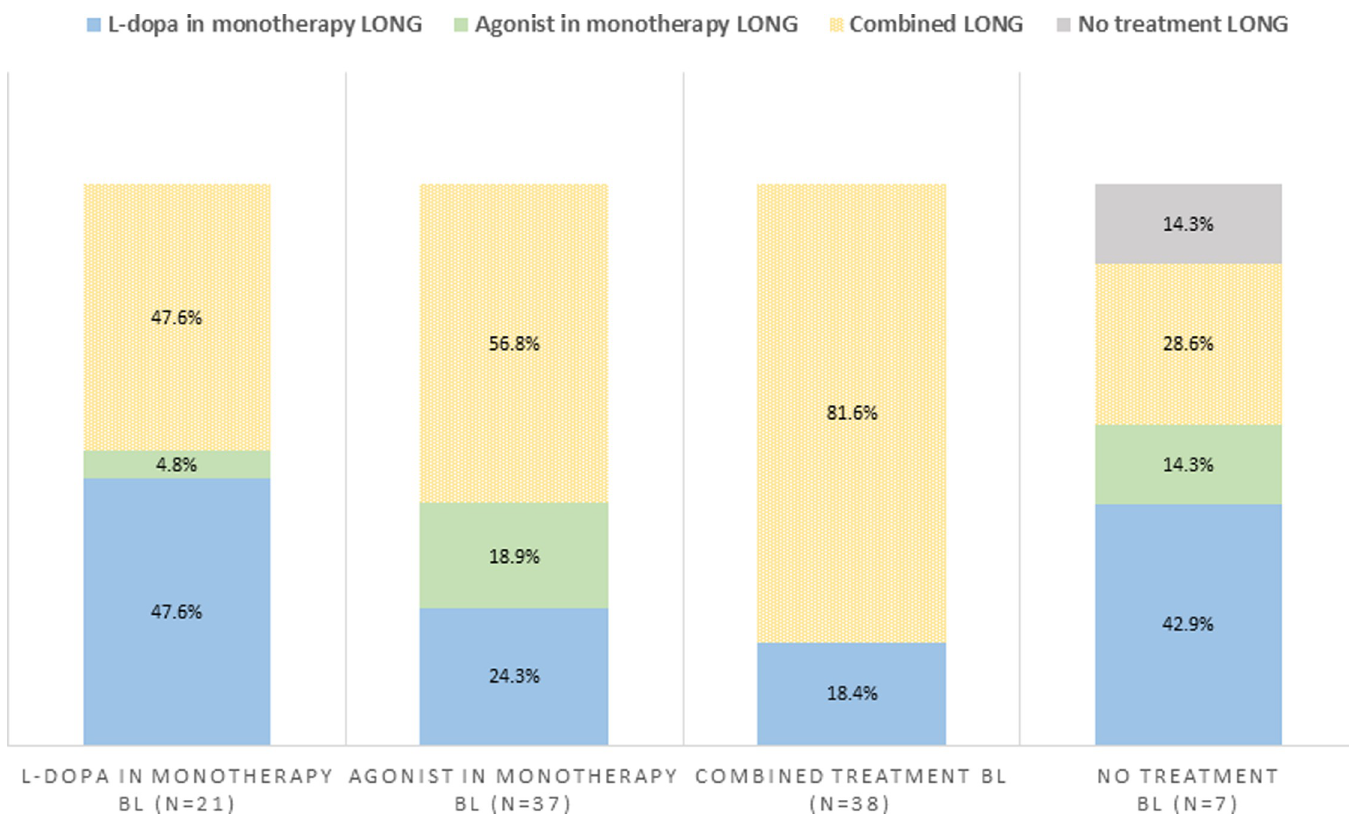
Fig 1. Change of treatment from baseline to follow-up. Abbreviations: BL: Baseline; LONG: Longitudinal, treatment at follow-up.